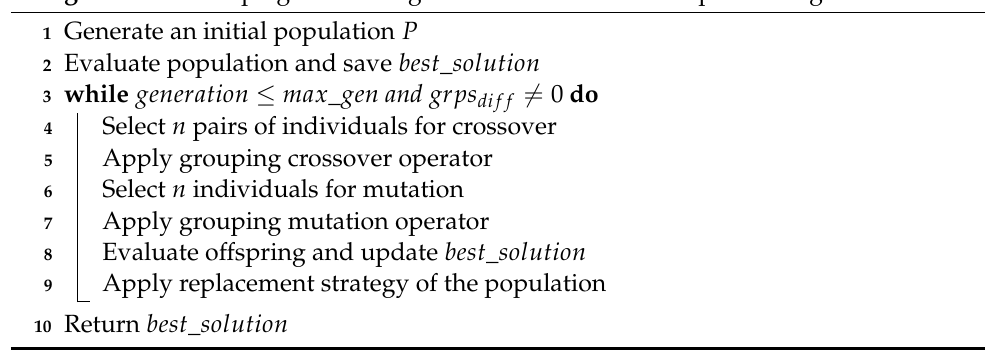
Algorithm 1: Grouping Genetic Algorithm for variable decomposition algorithm.